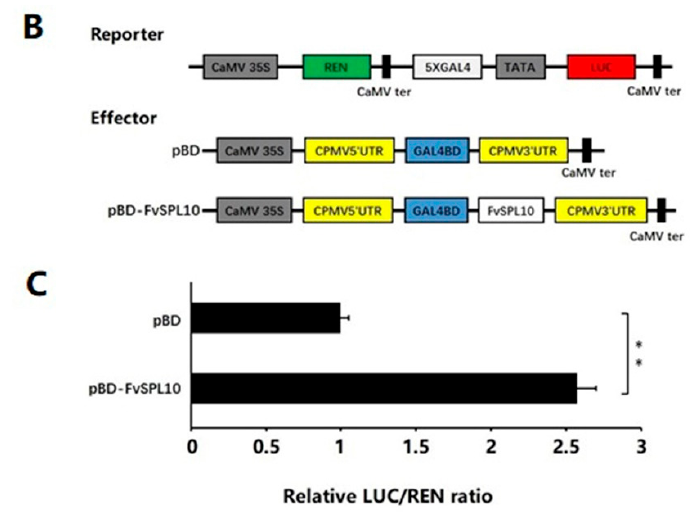
Figure 2. Subcellular localization and transcriptional activity analysis of FvSPL10 . ( A ) Subcellular localization of FvSPL10 . Binary vectors containing GFP-FvSPL10 or GFP were transiently expressed in tobacco leaves through the Agrobacterium infiltration approach. The fluorescence was detected 48 h after infiltration, and the nuclei were stained by 4 ′ ,6-Diamidino-2-phenylindole (DAPI). Bar, 20 μ m. ( B ) Schematic representation of the reporter and effector constructs for transcriptional activity analysis. LUC, firefly luciferase; REN, renilla luciferase. ( C ) Transcriptional activation ability of FvSPL10 in tobacco leaves. Reporter vector was co-transformed into tobacco leaves by Agrobacterium with pBD empty vector control or FvSPL10 , respectively. Each value represents the means of six biological replicates. The ratio of LUC/REN of the pBD control was used as a calibrator (set to 1). Double stars represent a significant difference between the sample and control at p < 0.01, based on the Student’s t -test.